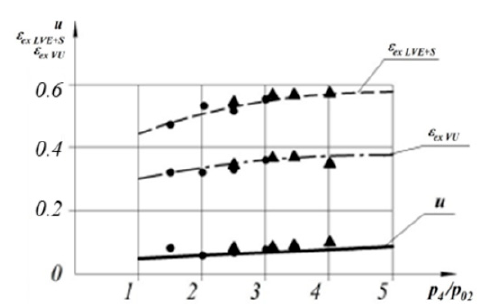
Figure 9. Dependence of achievable LVE performance indicators from the degree of pressure in-